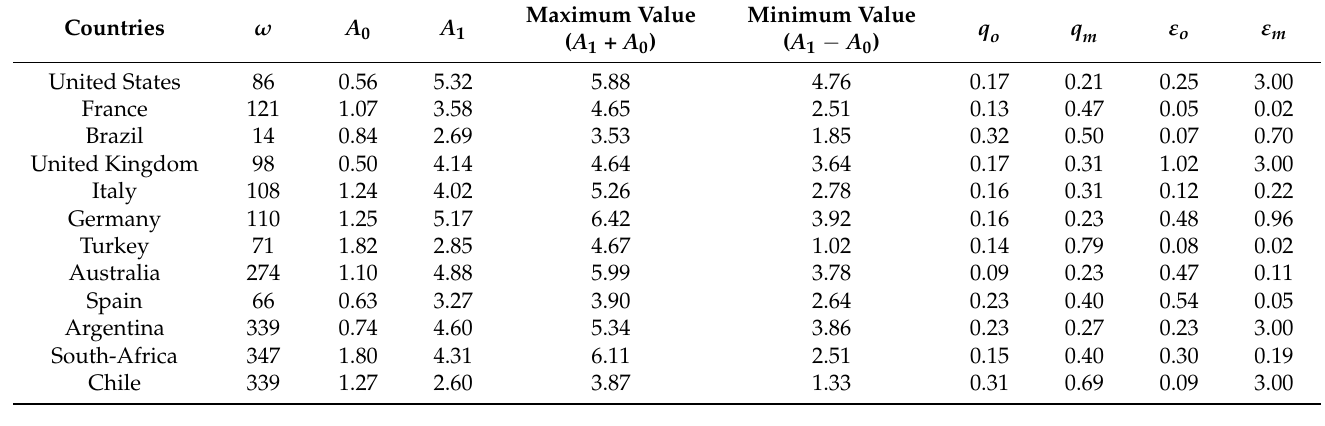
Table 3. Results of fitted parameters for the selected countries of this study.